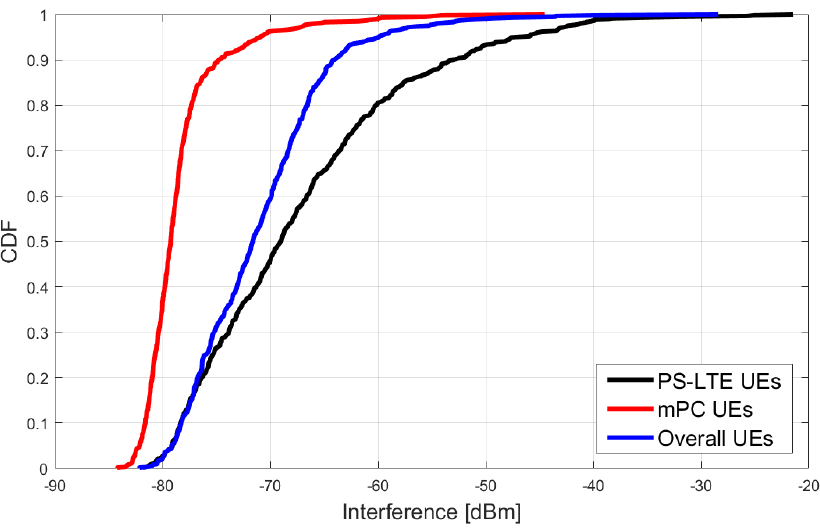
Figure 4. User equipment (UE) average throughput.